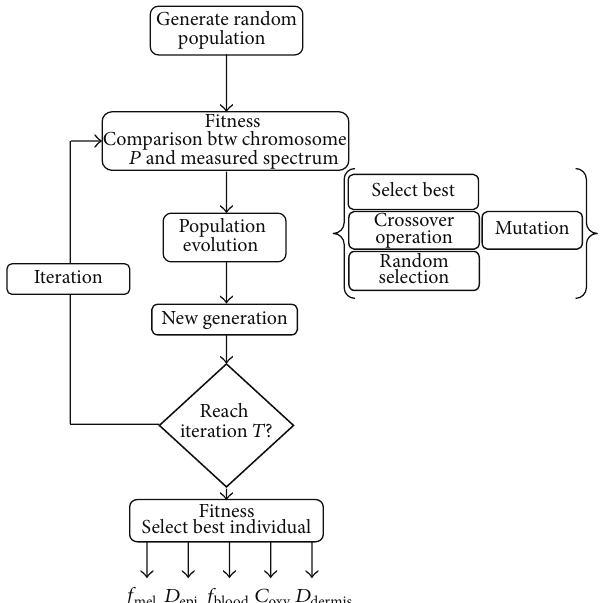
Figure 5: GA implementation for the inverse Kubelka-Munk model. GA is based on the evolution of a population, each step is summarized, fitness function to classify the population, population evolution to improve the solution, and parameter retrievals after 𝑇 iterations.